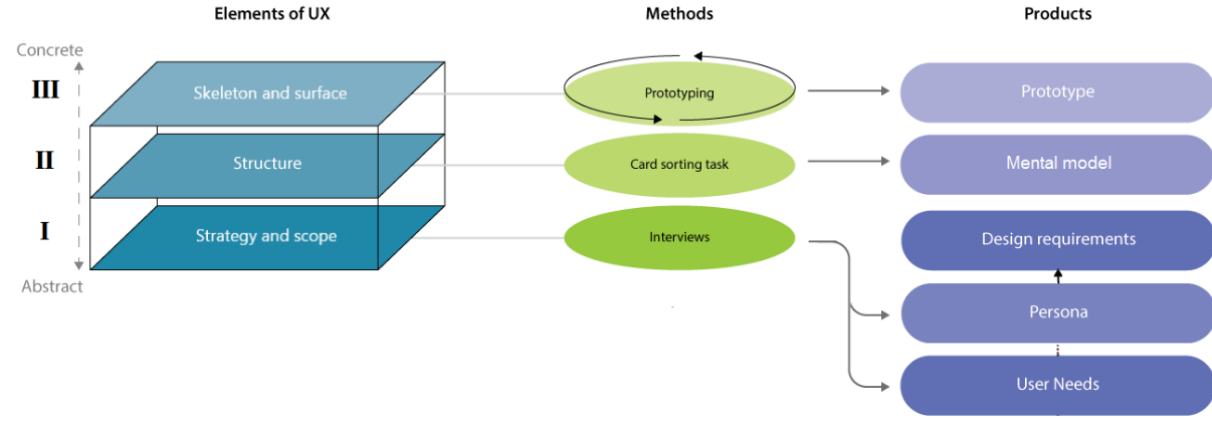
Figure 4. The EMP-framework. The framework is to be read from the bottom (ie, abstract considerations) to the top (ie, concrete considerations). The lines indicate the connection between the elements and the methods. The arrows point to the products that will result from the